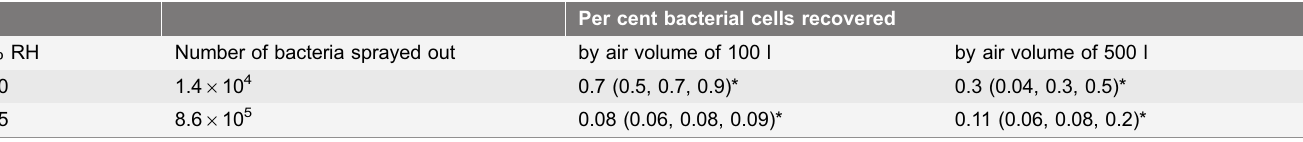
Per cent bacterial cells recovered